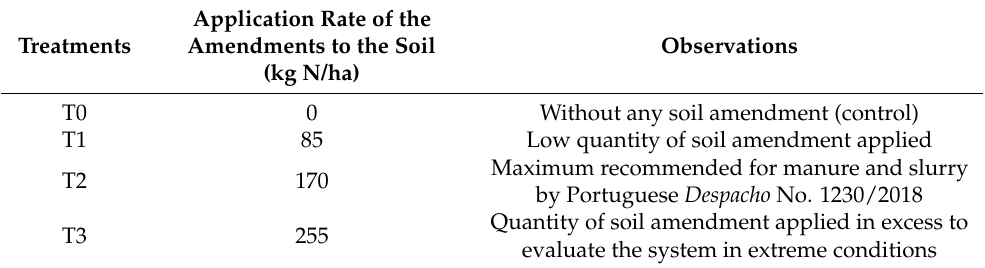
Table 2. Conditions to test the amendments (SS, DSS, DSSA, and COF) to the soil. Application Rate of the Treatments Amendments to the Soil Observations (kg N/ha) T0 0 Without any soil amendment (control) T1 85 Low quantity of soil amendment applied Maximum recommended for manure and slurry T2 170 by Portuguese Despacho No. 1230/2018 Quantity of soil amendment applied in excess to T3 255 evaluate the system in extreme